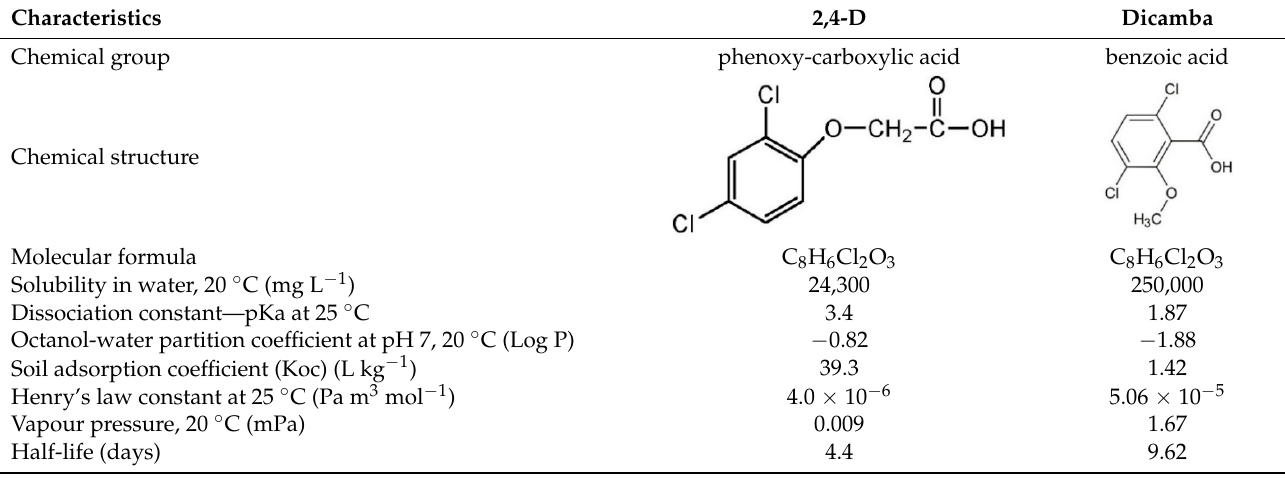
Table 1. Physicochemical characteristics of the herbicides 2,4-D and dicamba, without considering their salt formulations.